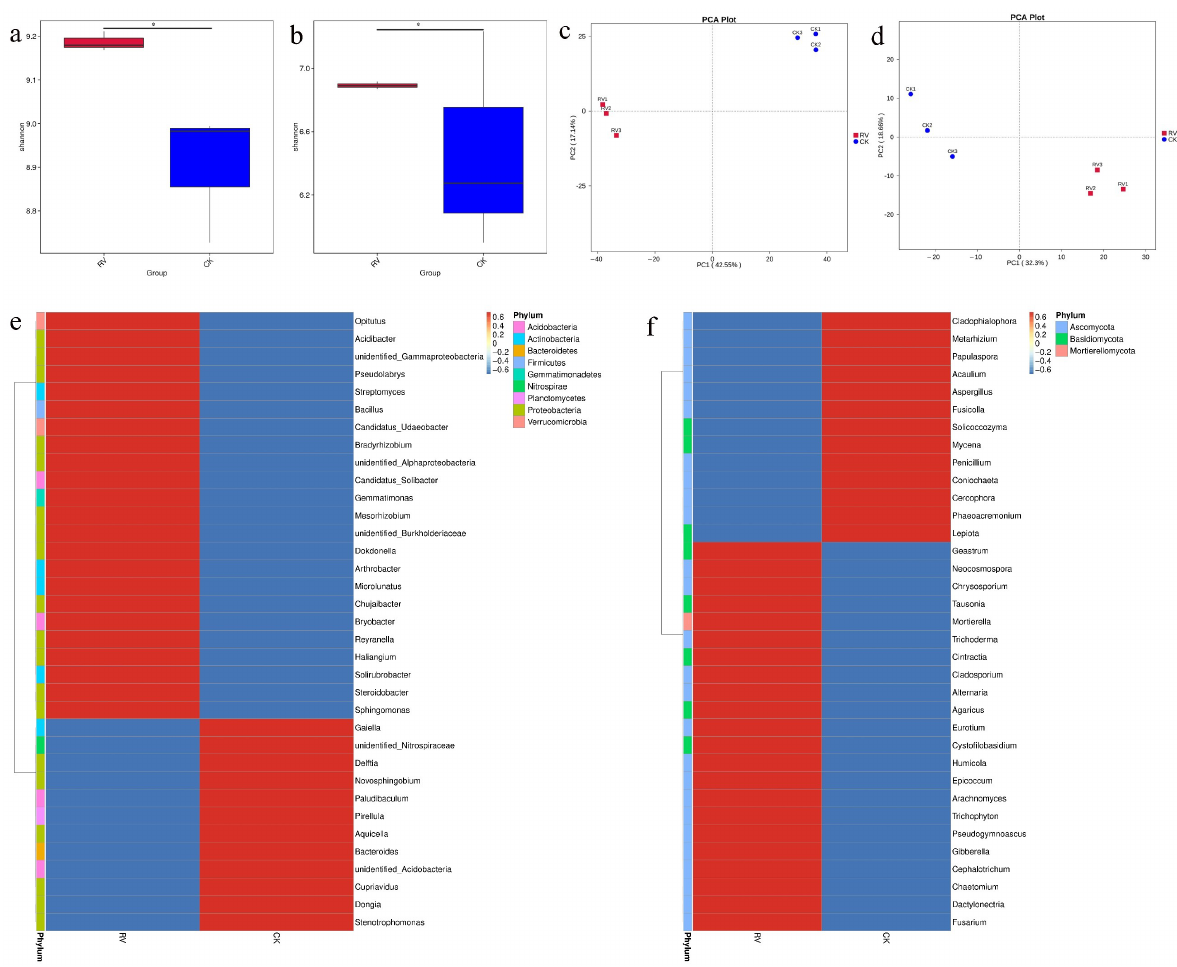
Figure 3. Effects of root-zone aeration on the alpha diversity index, PCA plot, and species abundance clustering heatmap: ( a ) Bacterial Shannon index. ( b ) Fungal Shannon index. ( c ) PCA at the genus level for bacteria. ( d ) PCA at the genus level for fungi. ( e ) Genus-level bacterial species abundance clustering heatmap. ( f ) Genus-level fungal species abundance clustering heatmap (* p ≤ 0.05).